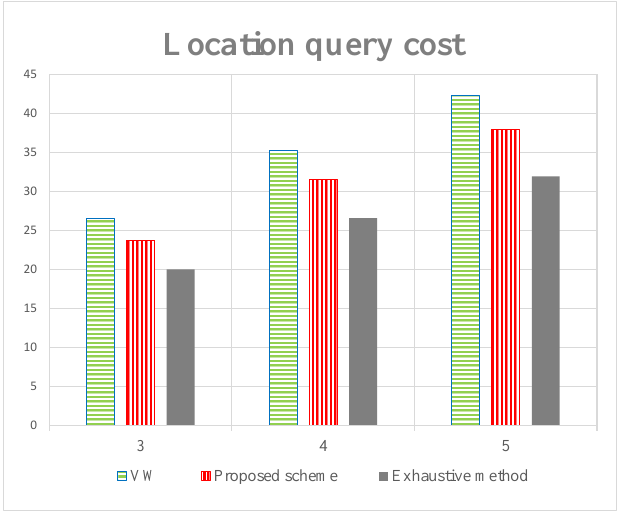
Figure 9. LBS query cost with different query requirement l 0 . ( k 0 = 10, λ 0 =